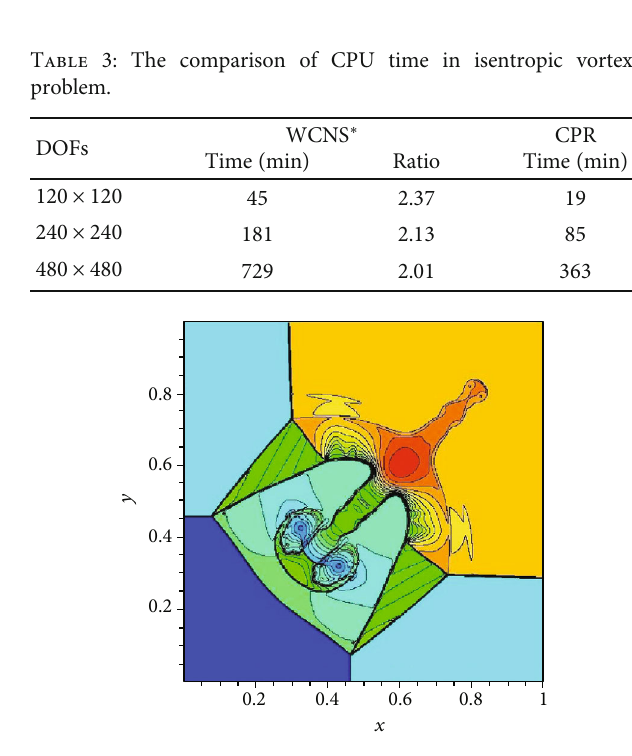
Figure 12: Result calculated by WCNS. DOFs = 960 × 960 . Density from 0.13 to 1.78 with 25 contours.